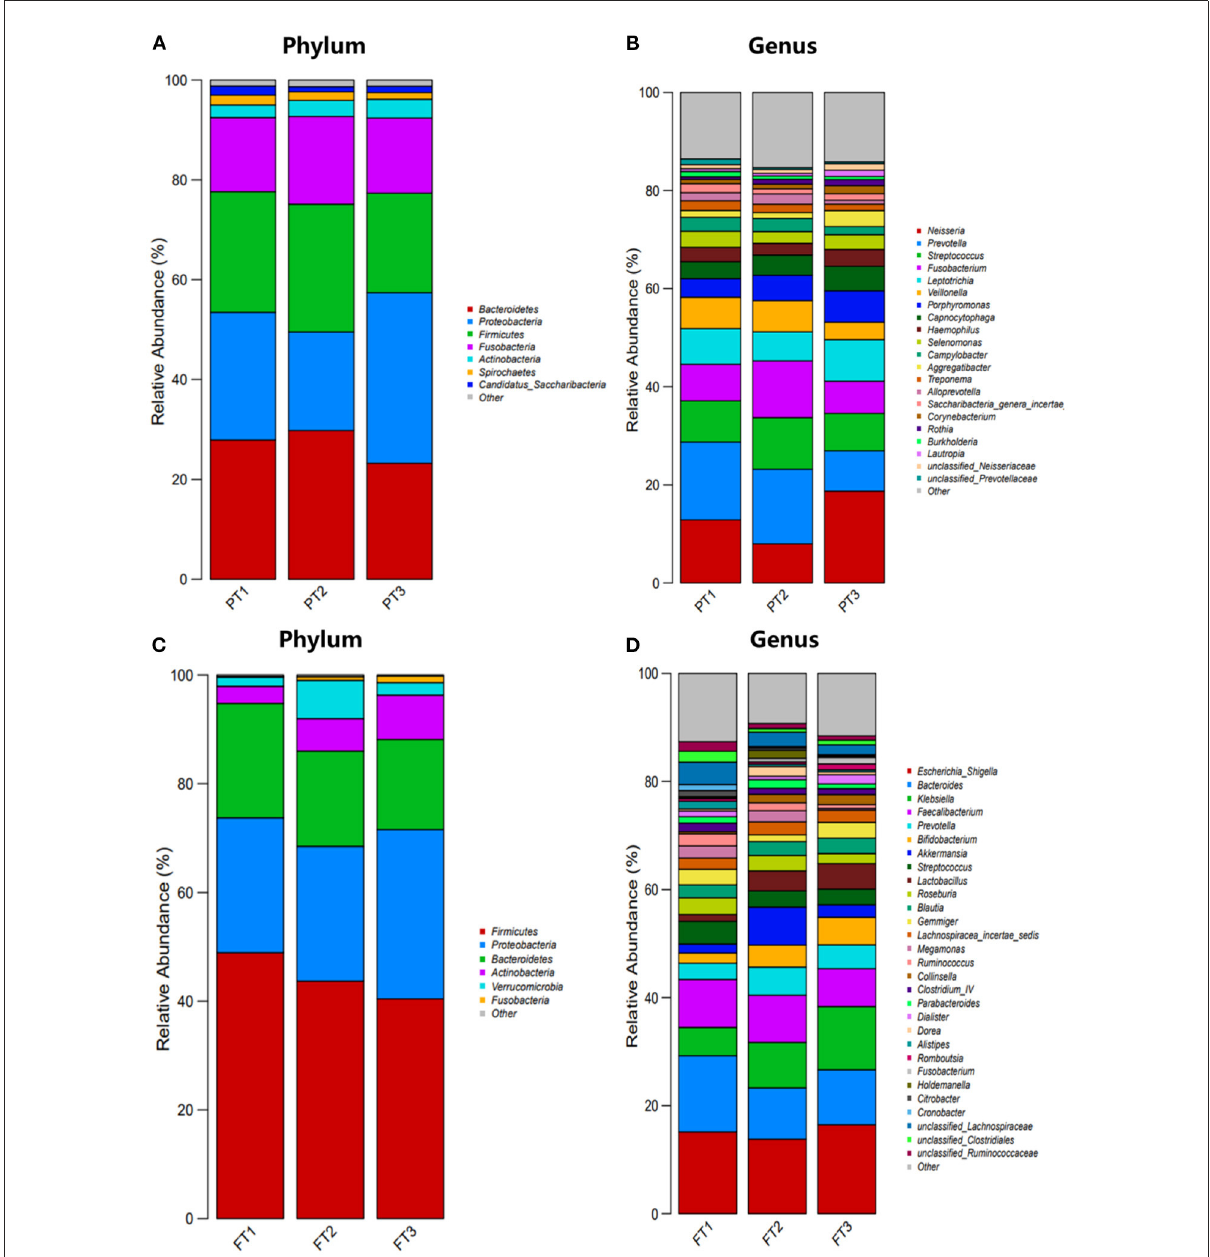
FIGURE6 Distribution of oral and gut microbiomes between the most anti-inflammatory diet group, no anti-inflammatory/pro-inflammatory diet group, and the most pro-inflammatory diet group. (A,B) represent the relative abundance of oral microbiomes at the phylum level and genus level, respectively; (C,D) represent the relative abundance of gut microbiomes at the phylum level and genus level,